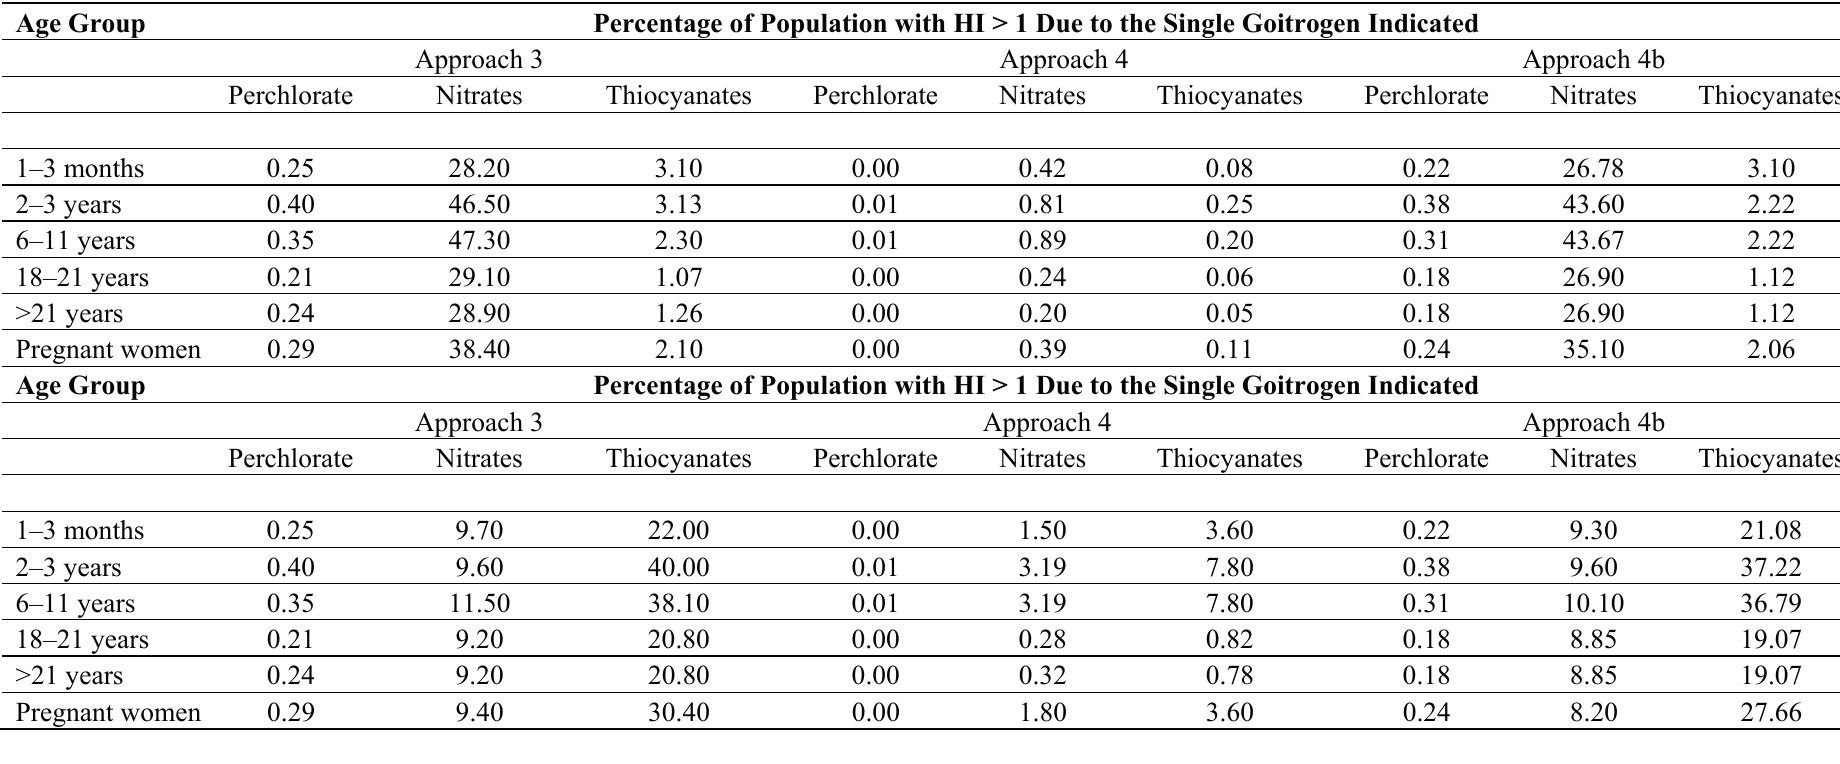
Table 4. Summary of results for the percentage of the total population with an HI value above 1, solely from the intakes of the individual goitrogens examined. The sums of these percentages are the values in Table 2, as Table 2 does not sub-divide results by goitrogen. The upper table contains the results without half-life correction, and the lower table presents the same results with half-life